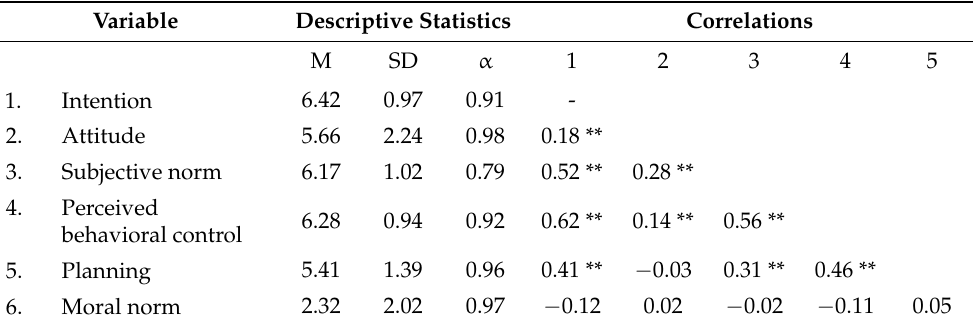
Table 3. Descriptive statistics, alpha reliability coefficients, and zero-order correlations among study